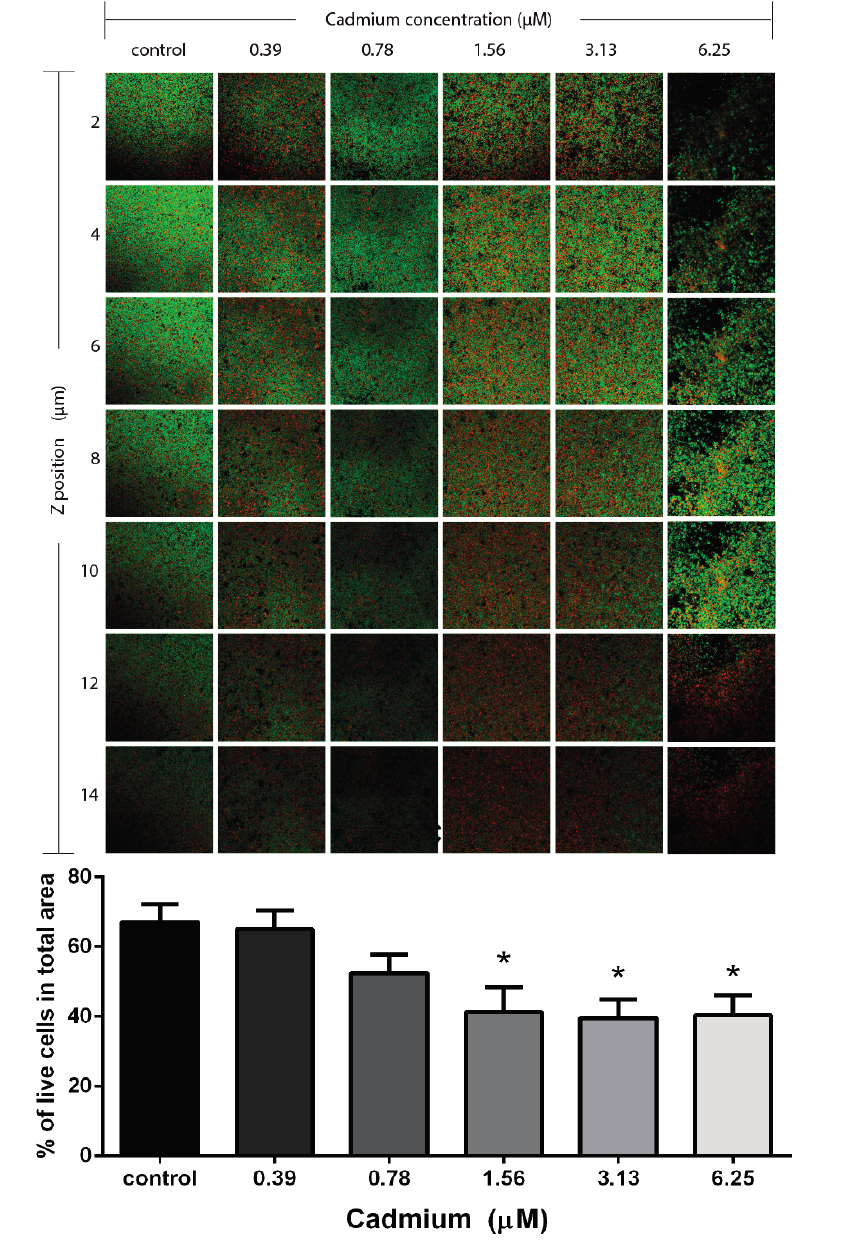
Figure 4. Bacterial viability in S. epidermidis (ATCC 35984) biofilms measured by confocal scanning laser microscopy. Non-viable bacteria were stained red, and total bacteria were stained green by using the propidium/SYTO green viability staining kit. Bacteria not stained in red were thus considered viable. Z-position images of controls and different cadmium concentrations (0.39–6.25 µM) were acquired in every 2 µm section. The graphic under the images shows the percentage of viable bacteria determined from all biofilm layers by image J